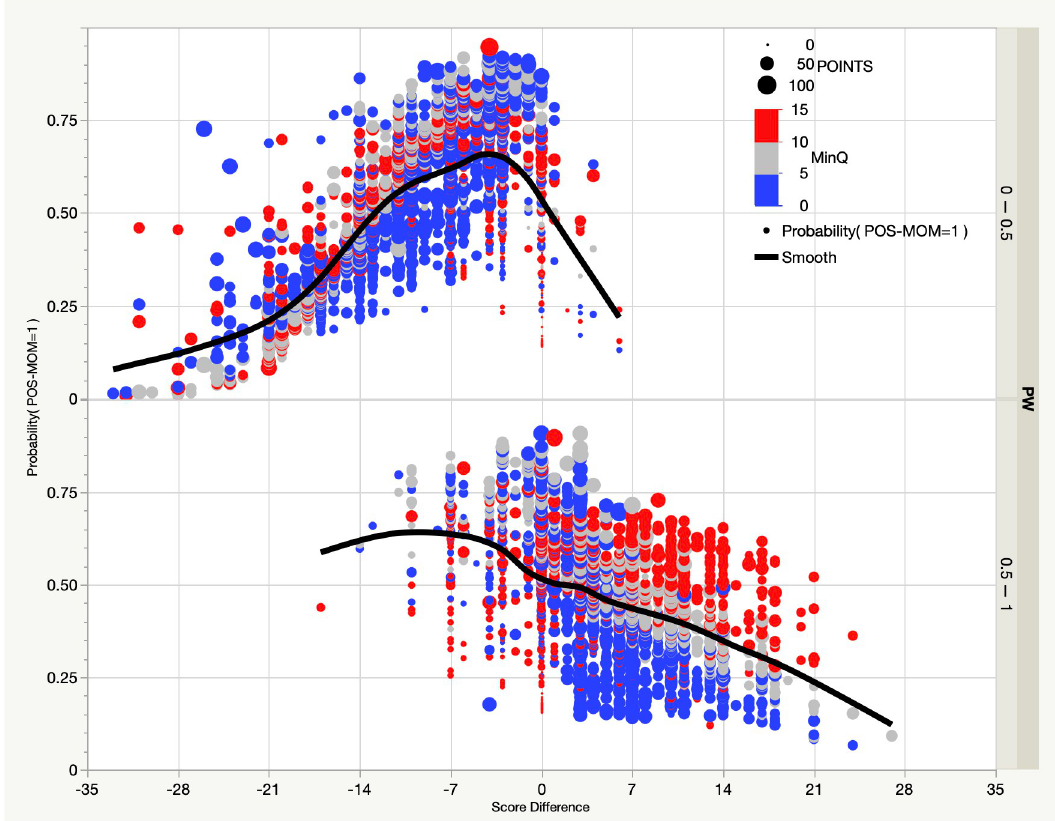
Fig 4. Artificial neural network (ANN) predictions of probability of momentum, defined as a streak of minimum length three increases in home team win probability, beginning with possession of the ball by the home team, where all inputs are at the start of the streak. Shown are the score difference (relative to the home team, where negative indicates the home team trailing), minutes remaining in the quarter (colors, where red, grey and blue are 10–15 minutes, 5–10 minutes and less than 5 minutes, respectively), points scored by both teams by that point in the game (circle sizes), for conditions in which the home team win probability is less than (top) or greater than (bottom) 50%. The black lines show smoothed fits to the data.